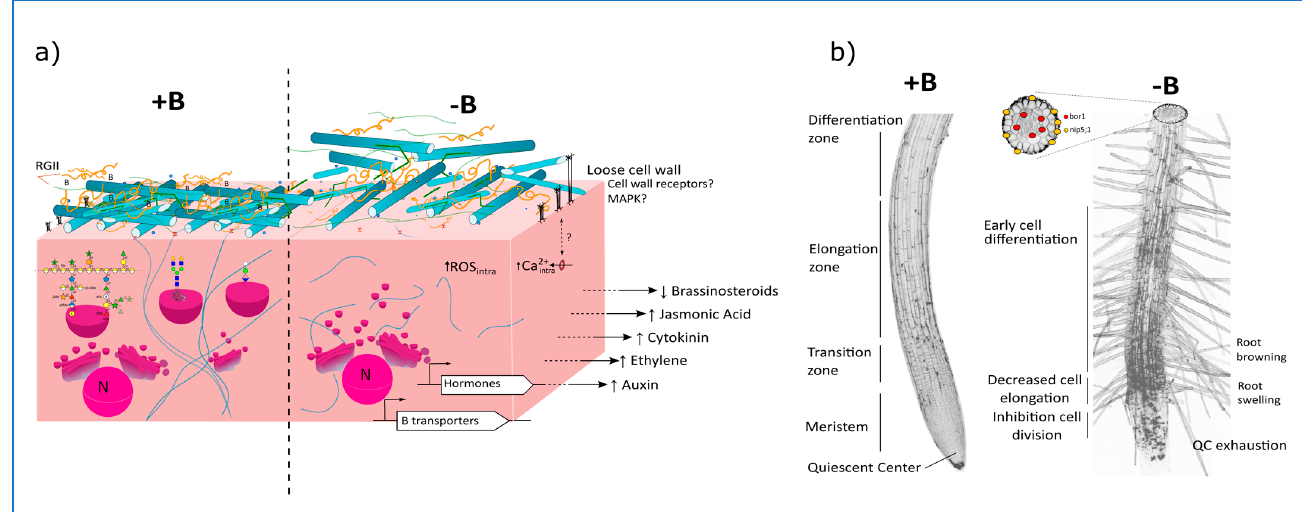
Figure 1. B deficiency symptoms and signalling pathways controlling B deficiency response in roots. ( a ) At the cellular level, boron sufficiency (+B) ensures the dimerization of rhamnogalacturonan II (RGII) and the bridging of other cis ‐ diol ‐ containing molecules such as glycoproteins and glycolipids,